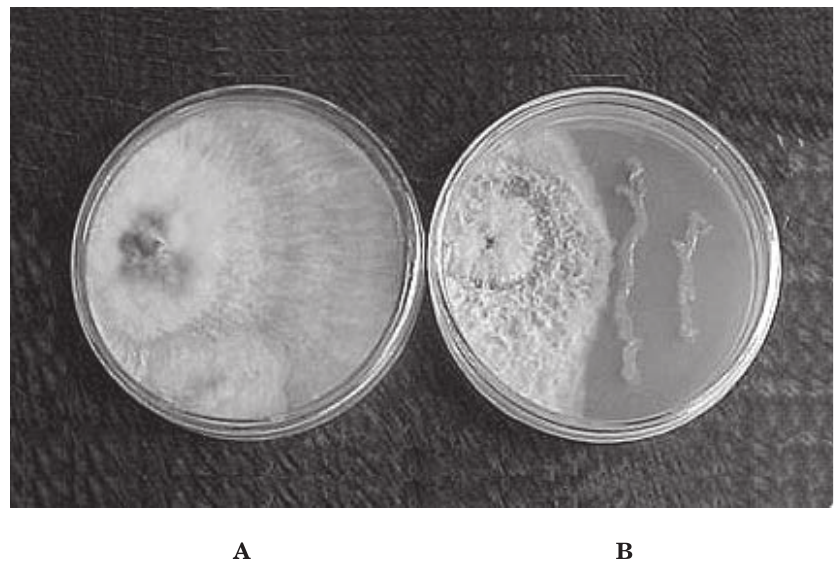
A Fig. 1. Effect of Pseudomonas fluorescens strain FP7 on in vitro growth of Colletotrichum gloeosporioides. A . Control ( C. gloeosporioides ) . B . FP7+ C. gloeosporioides.